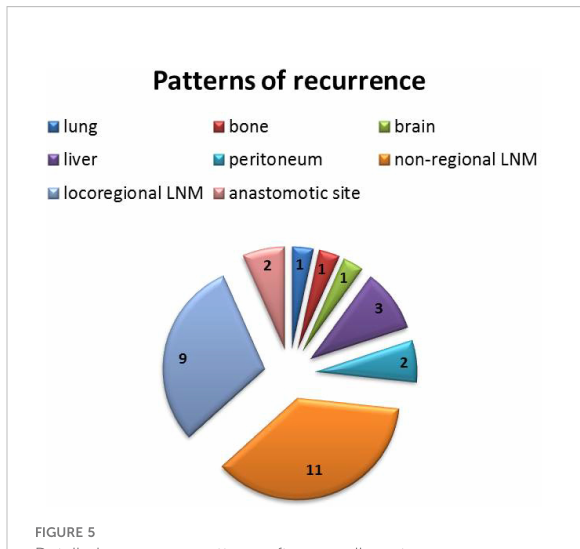
FIGURE 5 Detailed recurrence patterns after neoadjuvant immunochemotherapy. There were 19 (63.3%) cases with distant recurrence and 11 (36.7%) cases with local